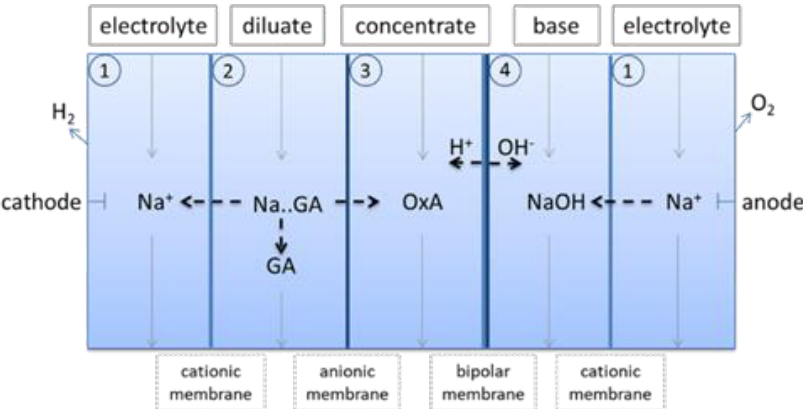
Figure 6. Setup of 2. electrodialysis for the removal of oxalic acid and to further reduce the sodium content.